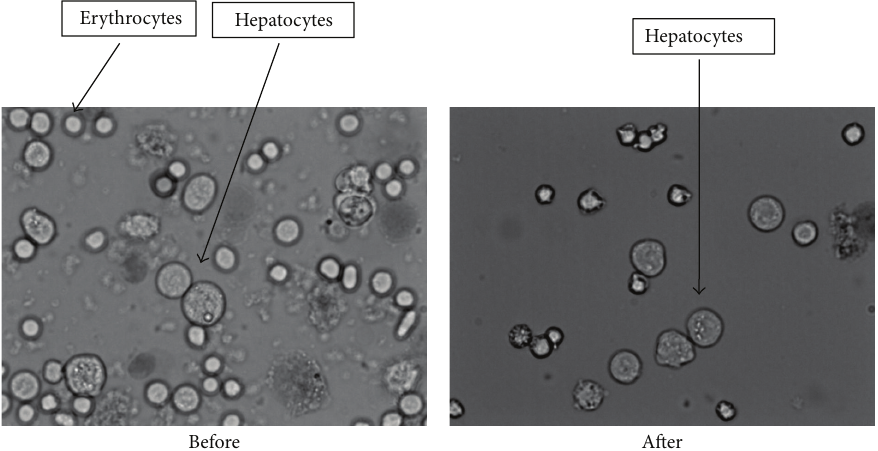
Figure 3: Pictures of the cellular suspension dyed with trypan blue and visualized with an optical microscope. We can see how the suspension looks before and after the lysis. Hepatocytes are bigger and have vesicles in their cytoplasm, while erythrocytes are smaller, round, and refringent.